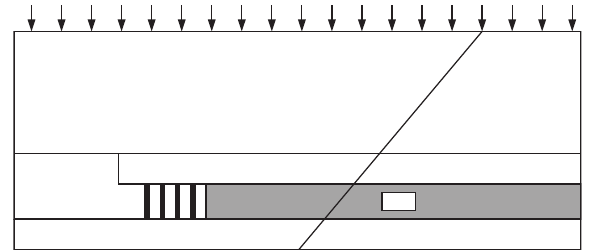
Figure 17: The numerical model of reverse direction fault (the periodical fracture).